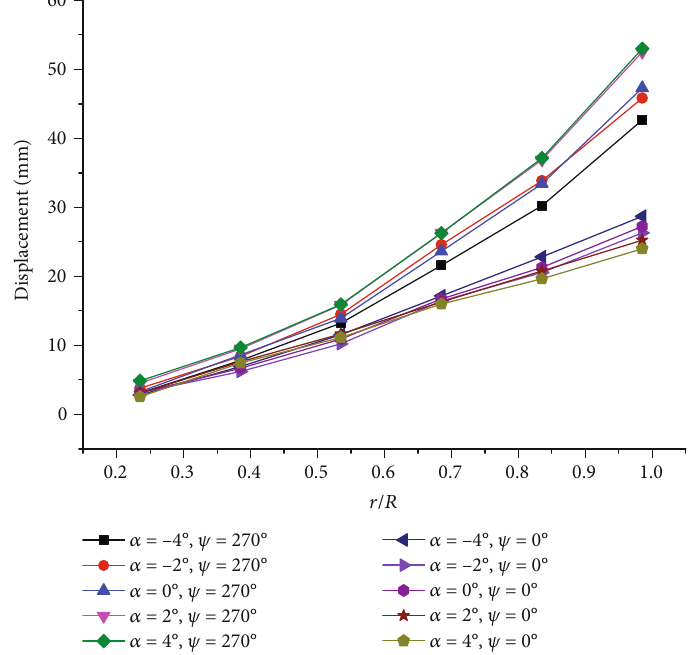
Figure 21: Blade displacements at ψ = 0 ° and 270 ° with six di ff erent radial